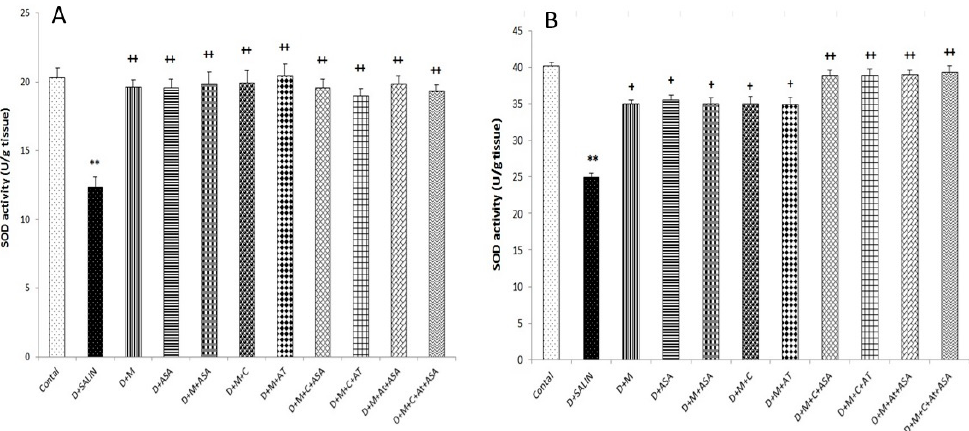
Figure 4. Superoxide dismutase (SOD) activity in the brain cortex ( A ) and hippocampus ( B ) tissues. Data are shown as mean ± SEM. ** p < 0.01 compared to control group, + p < 0.05 and ++ p < 0.01 compared to diabetic group. D, diabetic; M, metformin; ASA, aspirin; AT, atorvastatin; and C,